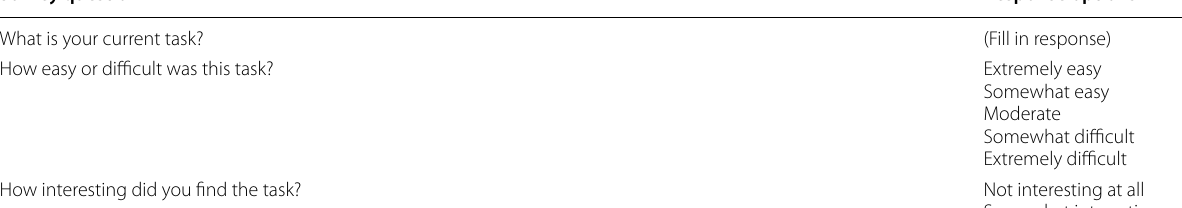
Table 3 Ecological momentary assessment survey questions Survey